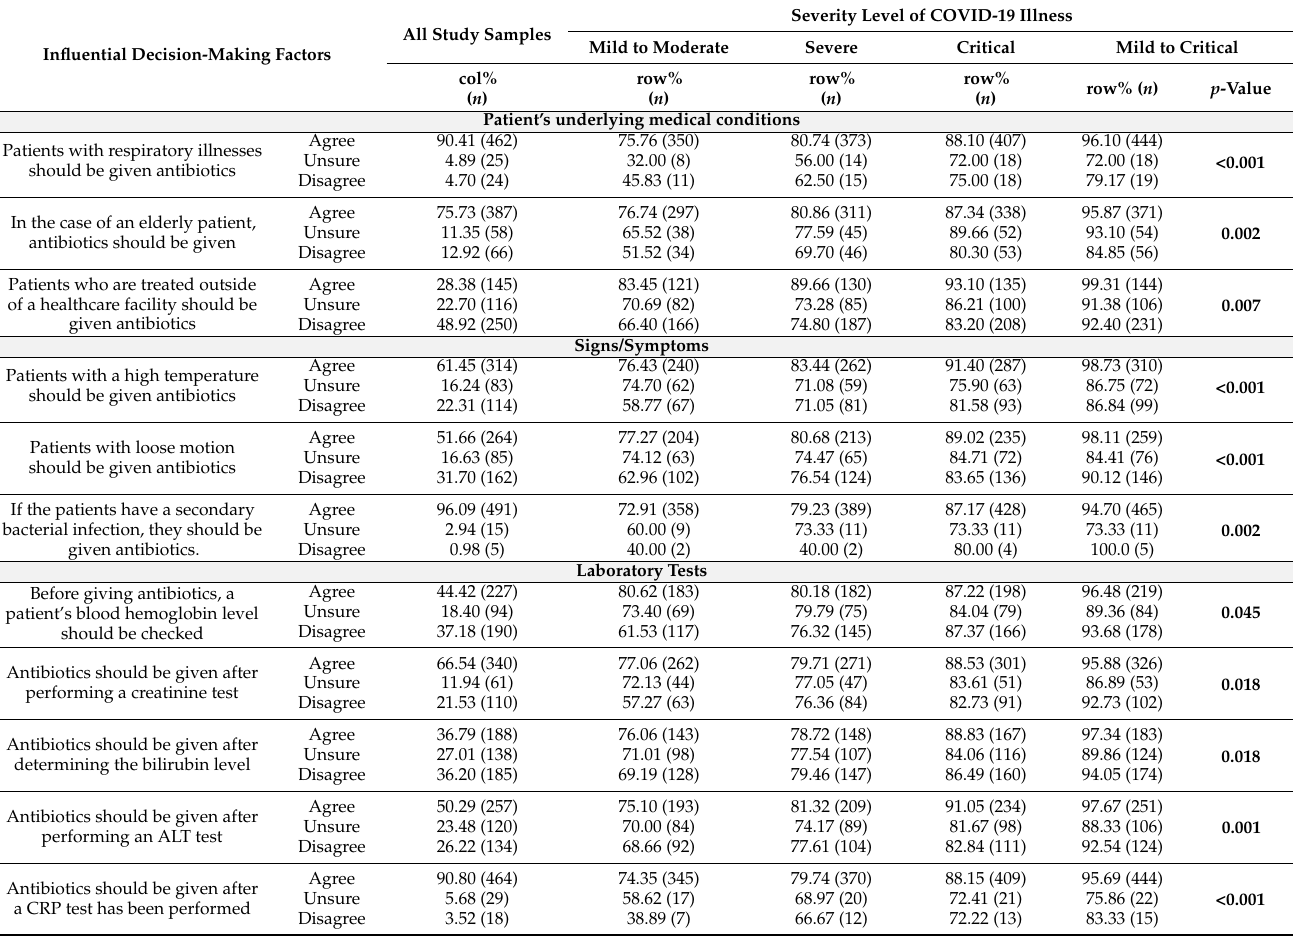
Table 2. Factors influencing decision making around prescribing antibiotics for treating COVID-19 patients, 2021